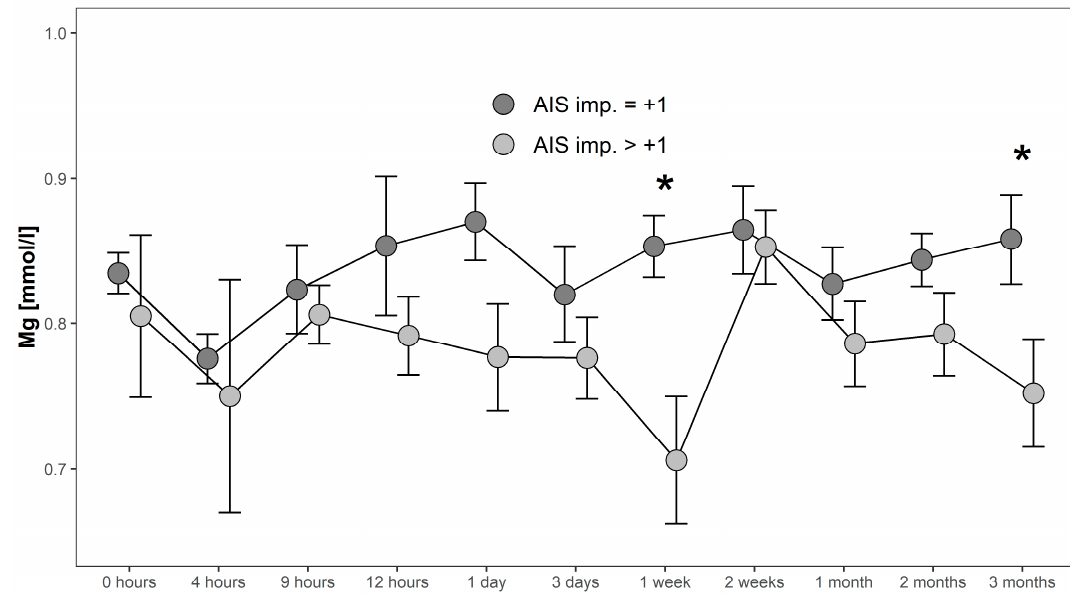
Figure 5. Mean Mg serum level comparison, presenting and comparing patients with neurological remission that presented an AIS conversion of 1 level (G1 AIS imp. = + 1) to those with an AIS level increase of more than 1 level (G1 AIS imp. > + 1) (C). Expressed as mean values ± standard error of the mean. The Mann-Whitney-U-Test assessed significant differences between both groups at each time-point (* p < 0.05).